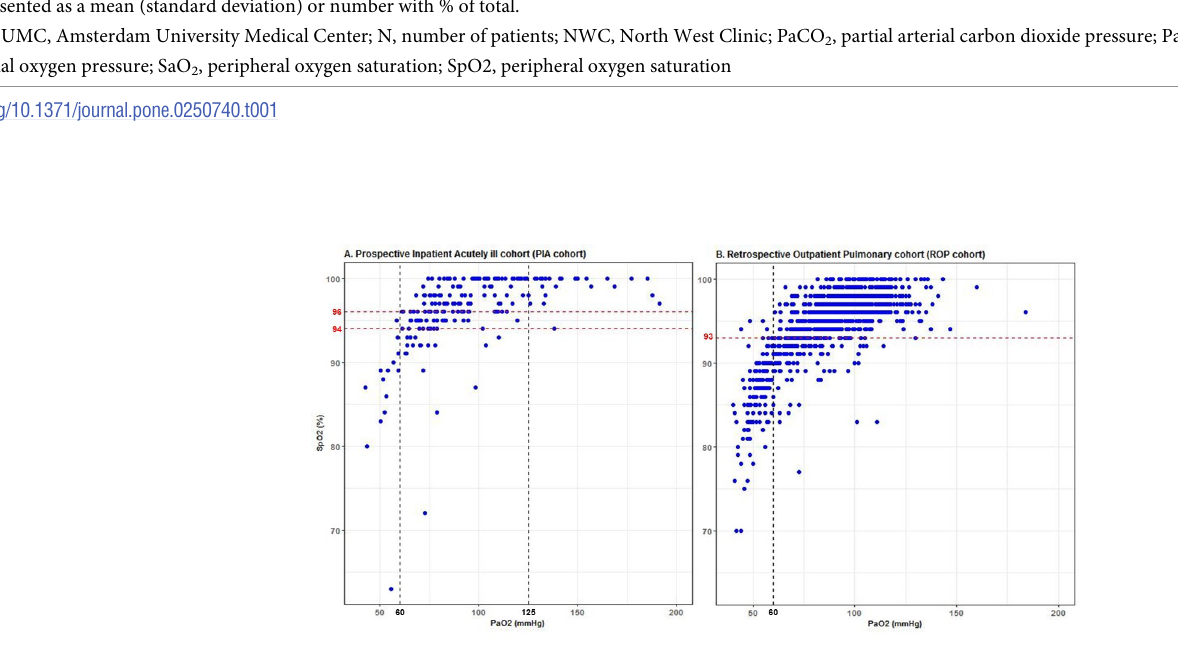
Fig 2. Scatterplots of the data pairs of the Prospective Inpatient Acutely ill cohorts and Retrospective Outpatient Pulmonary cohort. A. Prospective Inpatient Acutely ill cohort (PIA cohort) and B. Retrospective Outpatient Pulmonary cohort (ROP cohort). The black dashed vertical lines reflect the PaO 2 values of 60 mmHg and 125 mmHg. The red dashed vertical lines reflect the calculated lower and upper bounds to avoid hypoxemic and hyperoxemic PaO 2